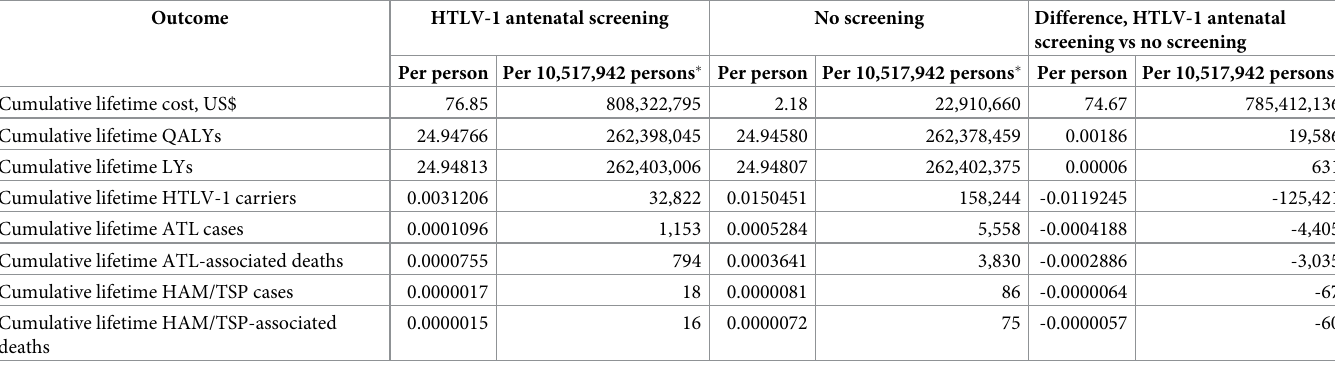
model. Seventh, twins were not taken into account in the analysis. Eighth, the model didn’t account for other HTLV-1-associated diseases such as HTLV-1-associated uveitis, infective dermatitis, bronchiectasis, bronchitis, bronchiolitis, seborrheic dermatitis, Sjo¨gren’s syn- drome, rheumatoid arthritis, fibromyalgia, and ulcerative colitis. Finally, there are different Table 3. Economic and health outcomes of HTLV-1 antenatal screening vs no screening.